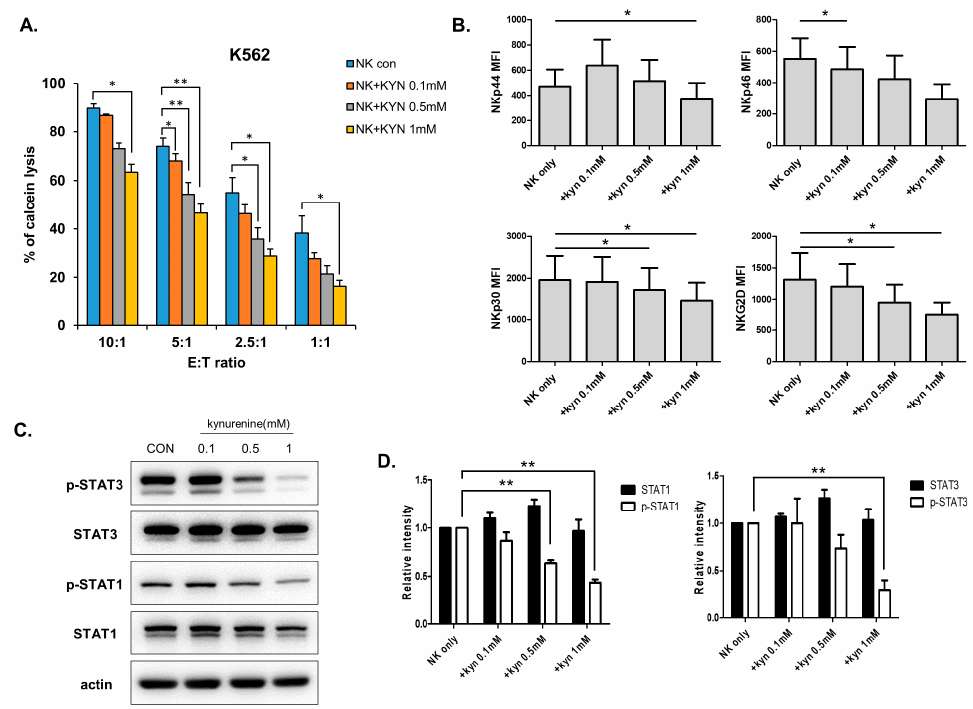
Figure 3. Kynurenine directly inhibits NK cell activity and NK receptor expressions. ( A ) NK cells were cultured with IL-2 in the absence (blue) or presence of 0.1 mM (orange) or 0.5 mM (gray) or 1 mM (yellow) of L-kynurenine for 24 h and cytotoxicity against K562 cells was examined. Bars represent mean ± SD of three independent experiments. ( B ) Expressions of NK receptors, including NKp44, NKp46, NKp30, and NKG2D were detected by flow cytometry. Graphs represent mean values of mean fluorescence intensity (MFI) for three independent experiments. ( C ) Phosphorylation of signal transducer and activator of transcription (STAT)1 and STAT3 were analyzed by Western blotting after the treatment of kynurenine in NK cells. β -actin served as a loading control. ( D ) Relative intensity is defined as the intensity of the target protein normalized to β -actin. Bars represent mean ± SD of three independent experiments. Statistical analyses were performed using the paired two-tailed Student’s t -test. * P < 0.05 and ** P <